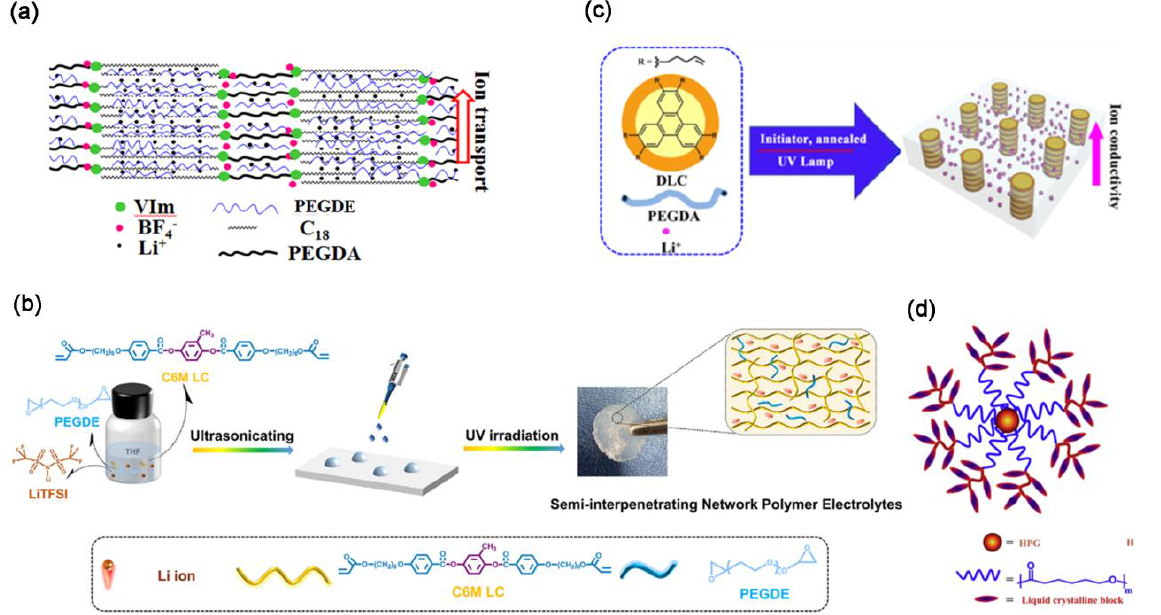
Figure 4. Liquid-crystal-based polymer electrolytes with desirable ionic channels based on different synthetic strategies. ( a – c ) Cross-linked (reproduced with permission [22,38,39]. Copyright 2019, 2018, and 2018, Royal Society of Chemistry, Royal Society of Chemistry, and American Chemical Society, respectively.) ( d ) Hyperbranched polymer electrolytes containing liquid crystal units. Reproduced with permission [41]. Copyright 2018, Elesvier.